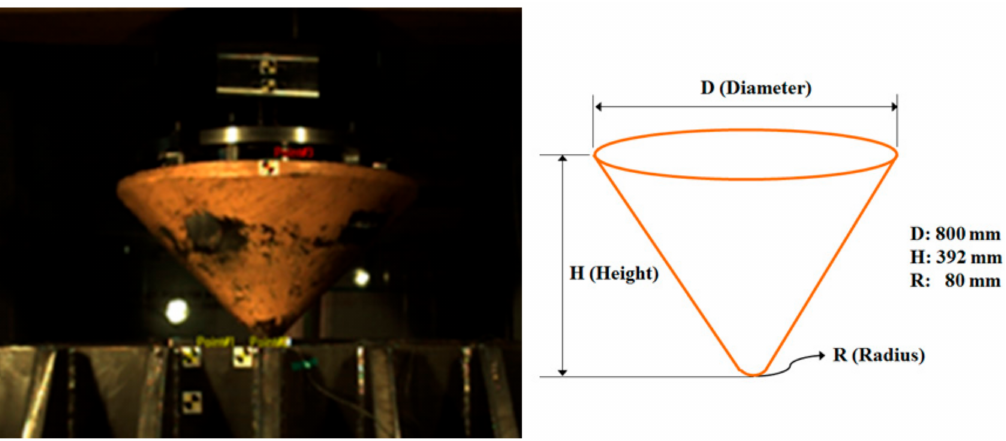
Figure 12. Cone-type dropped object